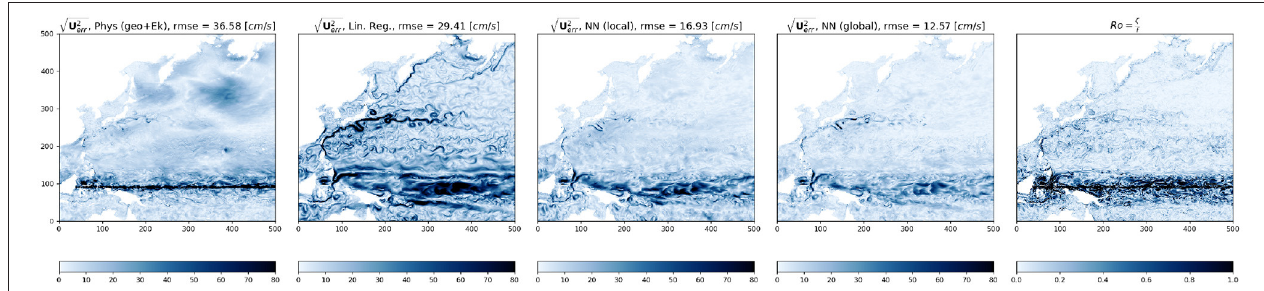
FIGURE 5 | Snapshot of model predicted root square errors for the physics based model (left) and the three different regression models—Linear regression (second from left), neural network, trained on this local domain (third panel) and neural network, trained on the globe (4th panel) compared side by side with the local Rossby Number (Ro, right panel) in the Kuroshio region indicated by the red box in Figure 2 . Note the large errors in all the model predictions near the equator.